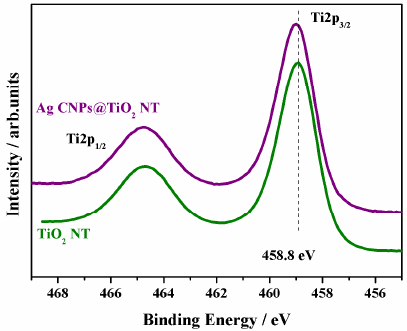
Figure 9. High-resolution X-ray photoelectron spectroscopy (XPS) spectra of Ti2p peaks recorded on titanium dioxide nanotubes annealed at 450 °C (green) and synthesized SERS substrate (violet).